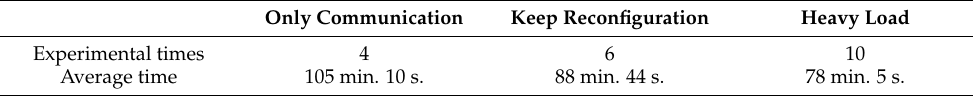
Table 3. Operation time data.